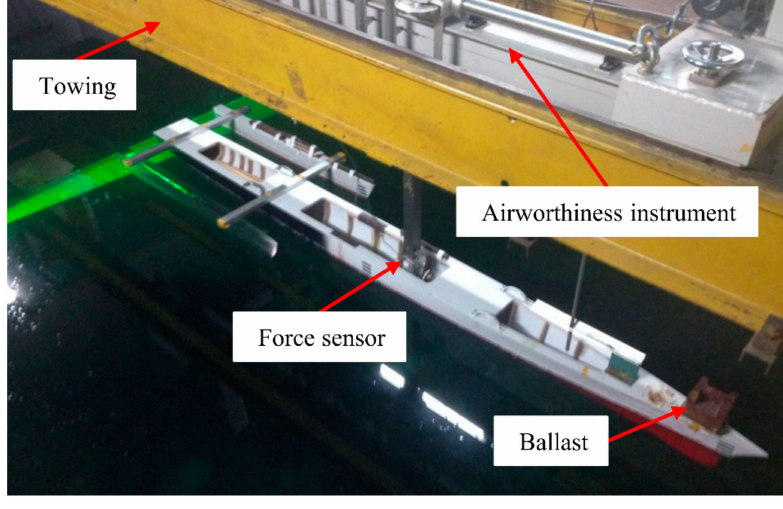
Figure 13. Model testing. Table 4. Comparison of resistance between numerical and experimental